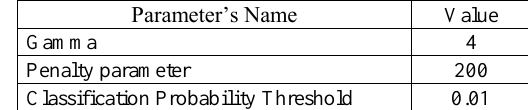
Table 3. SVM parameters for SAR image